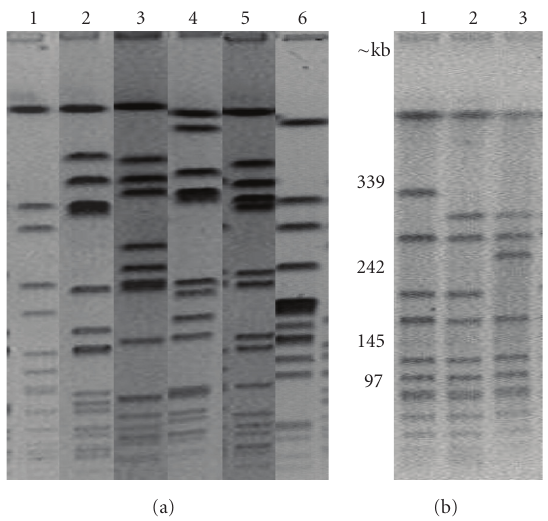
Figure 1: (a) Pulsed-field gel electrophoresis (PFGE) patterns of the SmaI-digested genomic DNA obtained from CA-MRSA isolates in Uruguay. Lane 1, pulsotype A (strain IH 23); lane 2, pulsotype B (strain IH 48); lane 3, pulsotype C (strain IH 46); lane 4, pulsotype D (strain IH 7); lane 5, pulsotype E (strain IH 22) and lane 6 pulsotype F (strain IH 69). (b) Pulsed-field gel electrophoresis (PFGE) patterns of the SmaI-digested genomic DNA obtained from CA-MRSA isolates in Uruguay. Lane 1, pulsotype A1 (strain IH 36); lane 2, pulsotype A (strain IH 44); lane 3, pulsotype A2 (strain IH